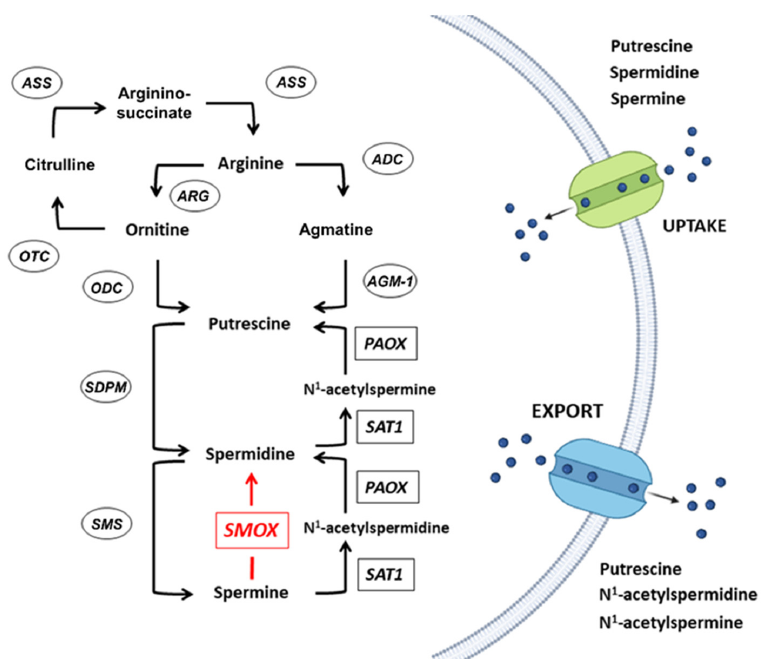
Figure 2. Polyamine’s metabolism. Enzymes involved in PA biosynthesis and catabolism are en- circled and boxed, respectively. ADC, arginine decarboxylase; AGM-1, agmatinase; ARG,